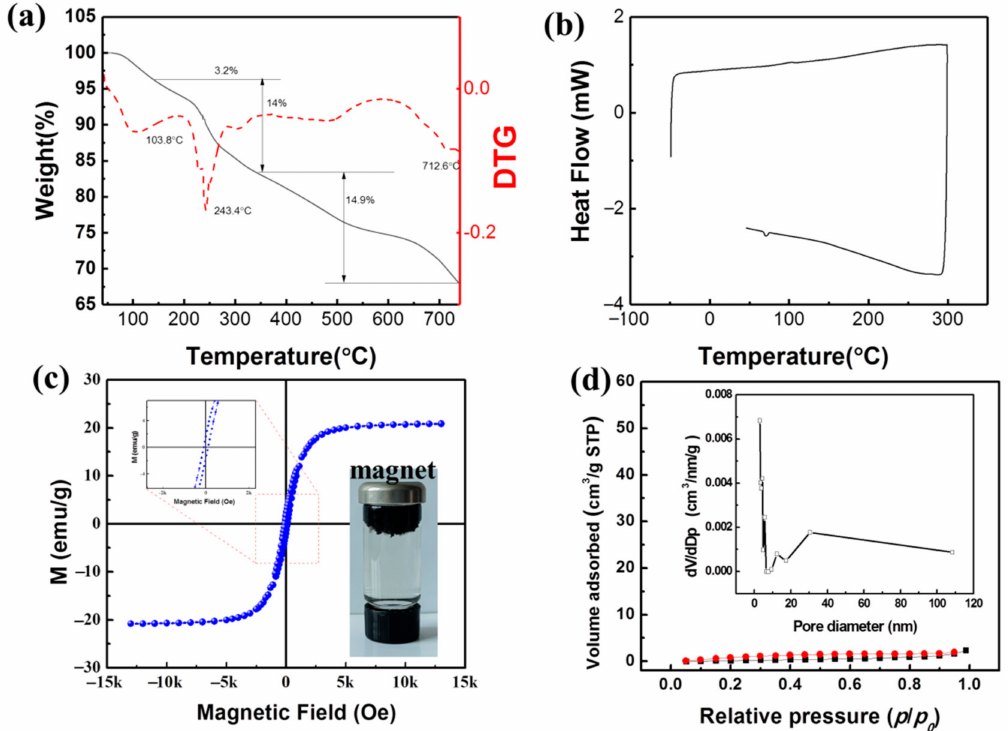
Figure 3. ( a ) TG and ( b ) DSC curves of MXCS/PAA; ( c ) magnetization curves of MXCS/PAA; ( d ) N 2 adsorption–desorption isotherm of MXCS/PAA. Inset: BJH pore size distribution of